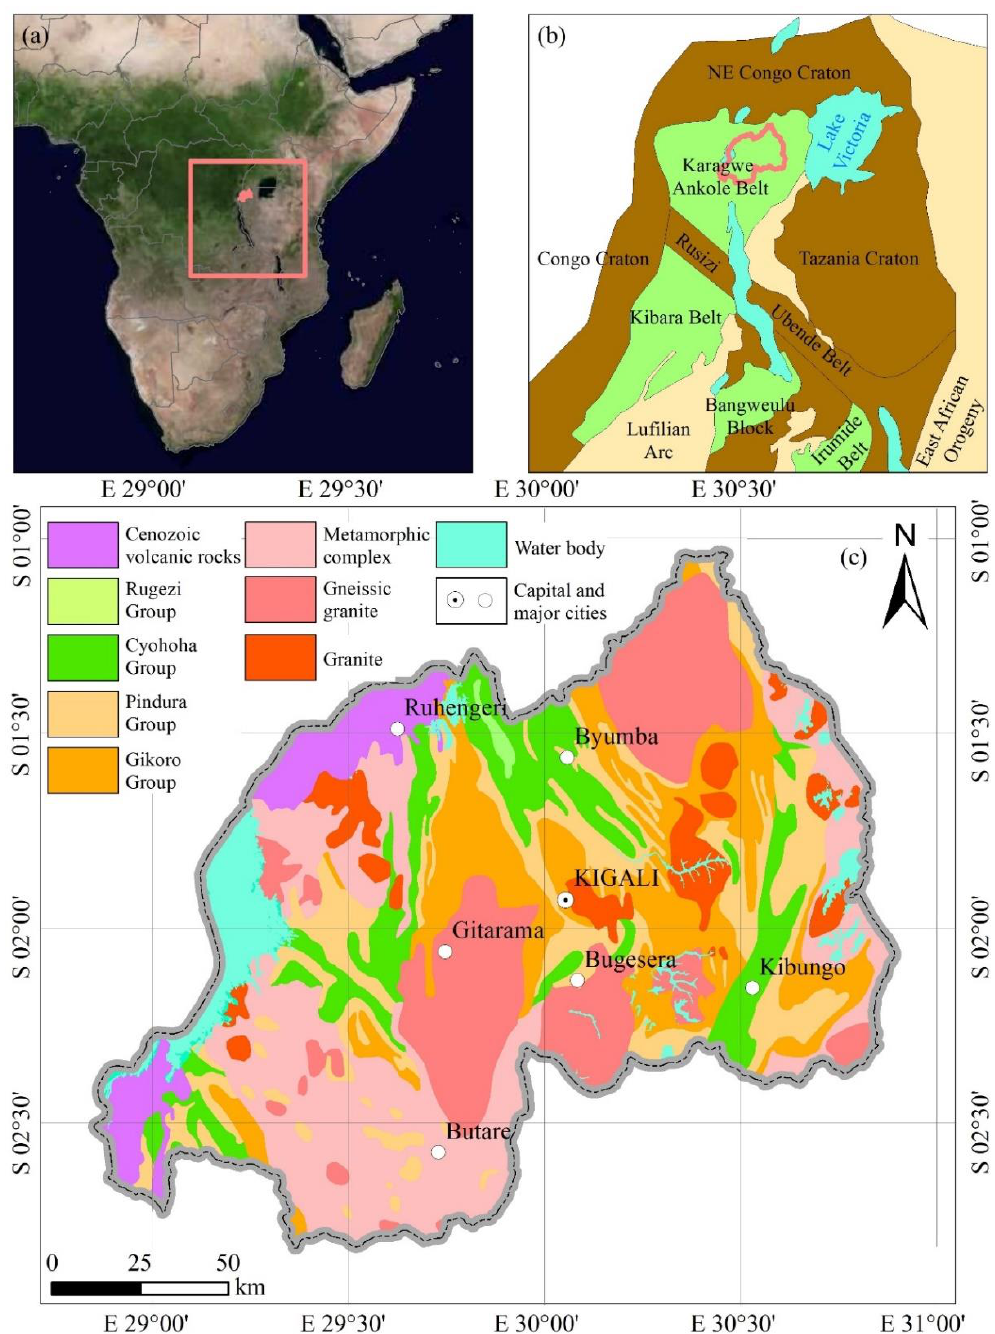
Figure 1. ( a ) Location in central Africa (https://www.naturalearthdata.com/ and Tianditu); ( b ) geological setting (adapted from [46]); ( c ) regional geological map of Rwanda (adapted from [53]).